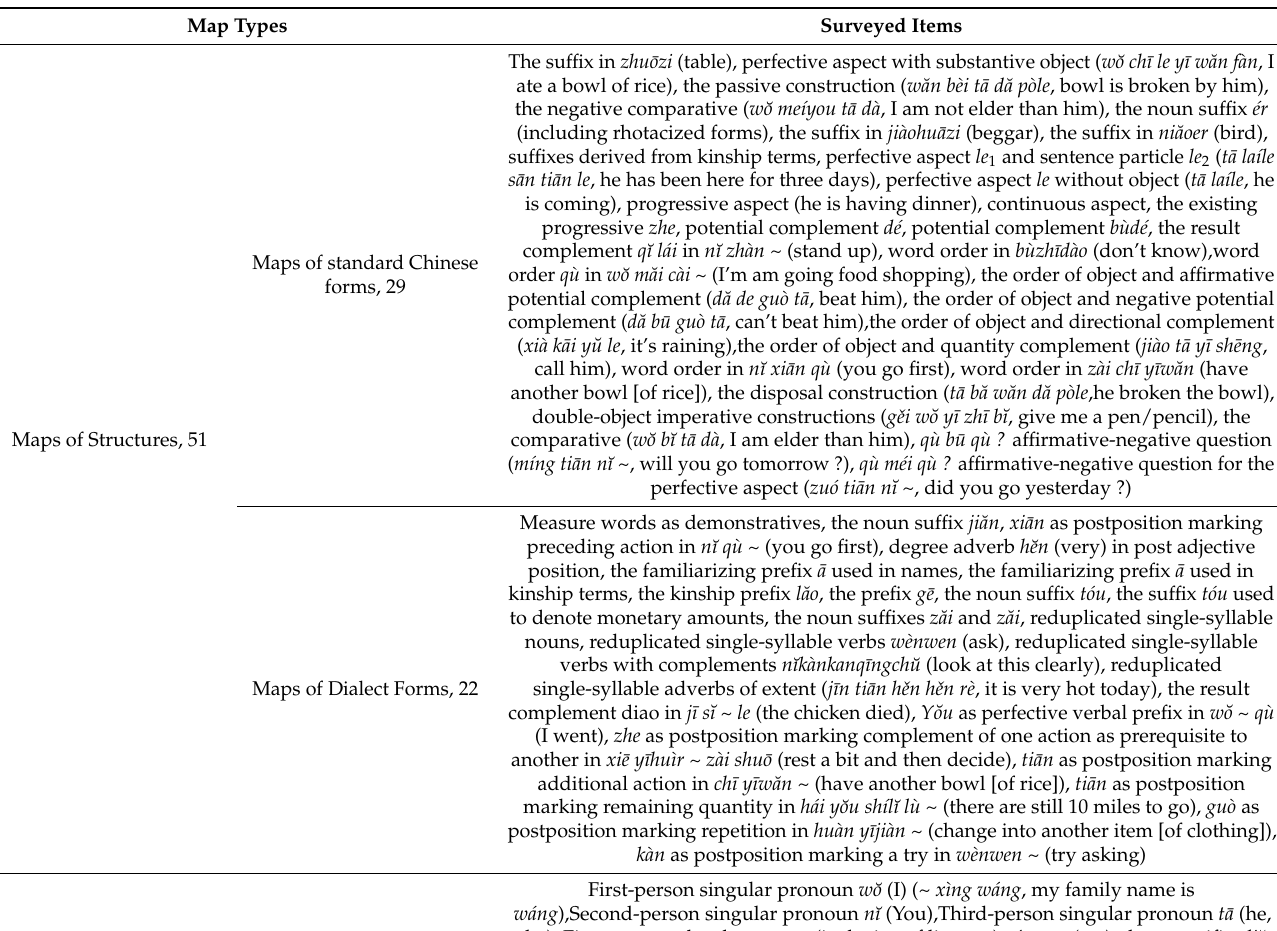
Table A3. Chinese dialects expressions of grammatical words, morphology, and syntax surveyed by the Linguistic Atlas of Chinese Dialects · Grammar